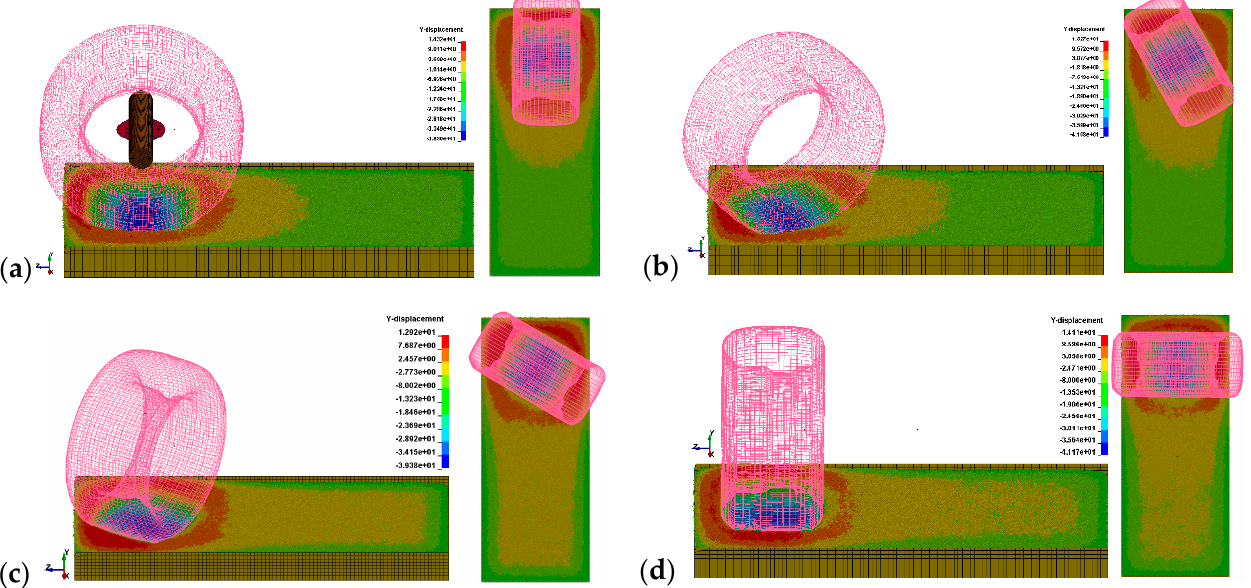
Figure 12. Map of the Y-axis DEM particles displacement counters as a result of the action of gravity for the following slip angles: ( a ) 0°, ( b ) 30°, ( c ) 60°, and ( d ) 90°.